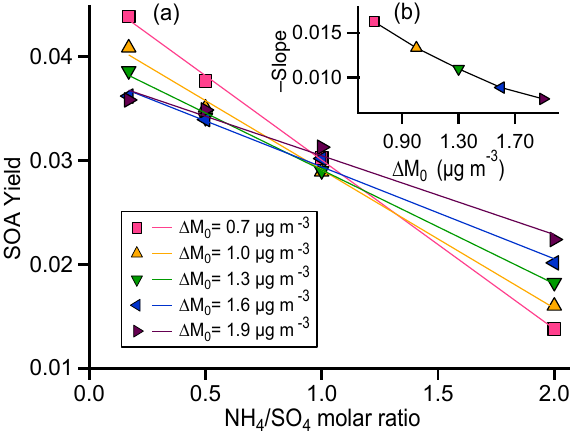
Figure 4. (a) SOA yield vs. NH 4 / SO 4 molar ratio in the initial pe- riod of photooxidation (approximately 0–1h) under high-NO x con- ditions. The colored lines represent the linear fitting of the markers. The SOA yields at specific (cid:49) M 0 values were retrieved from the plotting of SOA yields vs. (cid:49) M 0 in Fig. 3a. (b) The negative slope derived from the fitting of SOA yields with NH 4 / SO 4 molar ratios in (a) decreased with (cid:49) M 0